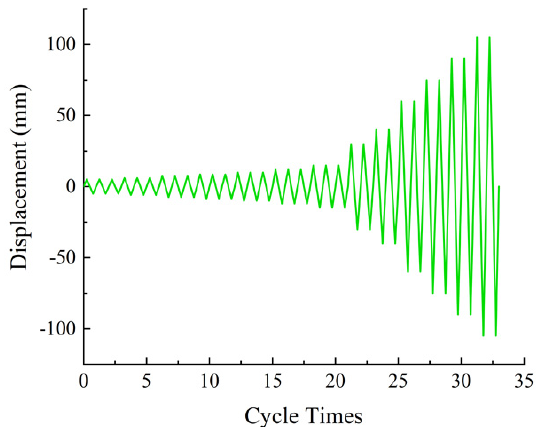
Figure 7. Test loading scheme.